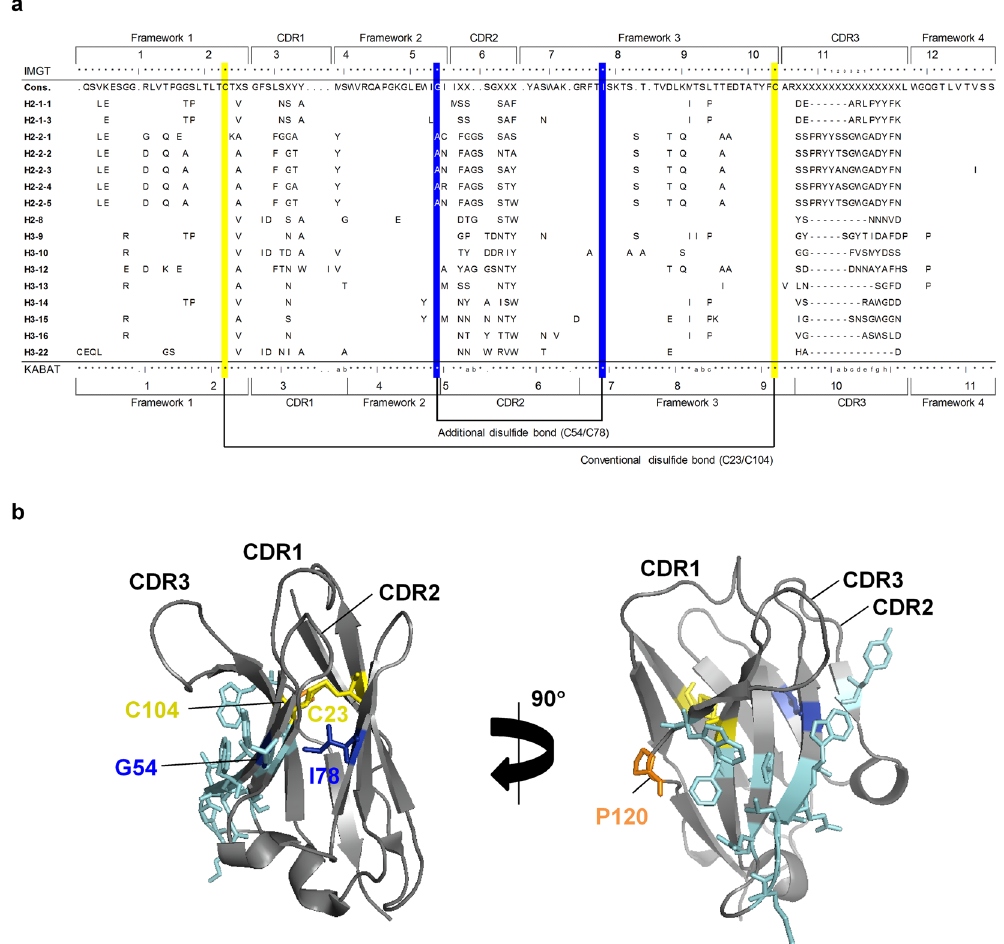
Figure 2. Primary and tertiary structures of rVHs ( a ) Amino acid sequences of the obtained 16 rVHs and their consensus (Cons.) sequences are aligned according to IMGT and KABAT numbering. For each obtained rVH, only amino acids different from consensus sequences are indicated. The Cys positions for C23-C104 and C54- C78 are linked with black lines and highlighted by yellow- and blue-filled frames, respectively. ( b ) The residues in the VL interacting surface (cyan or orange), a pair of Cys residues forming C23-C104 (yellow), and residues mutated to Cys for C54-C78 (blue) are indicated in the rVH structure (PDB ID: 4HBC). Figures were generated with PyMOL (The PyMOL Molecular Graphics System, 1.7.2.1 Schrodinger,